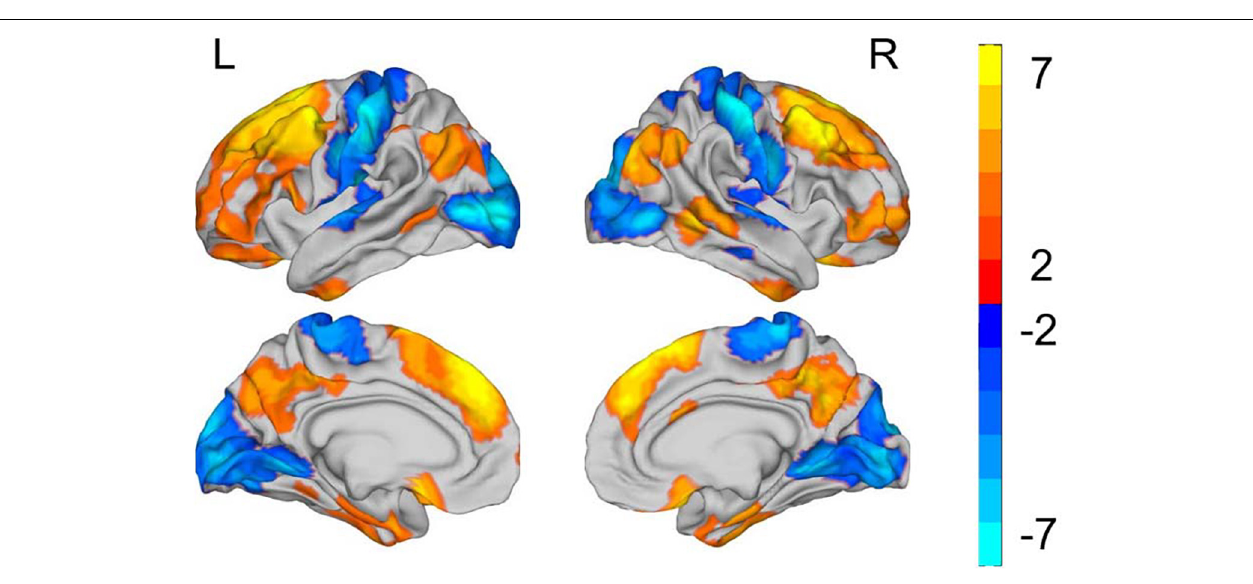
FIGURE 2 | Group differences in the surface-based 2dReHo. L refers to left side of brain. R refers to right side of brain. All results are shown after FDR corrected ( p < 0.05). The color bar represents T values of the two-sample t -test; the yellow regions represent higher and blue regions represent lower 2dReHo in the patient group compared with the control